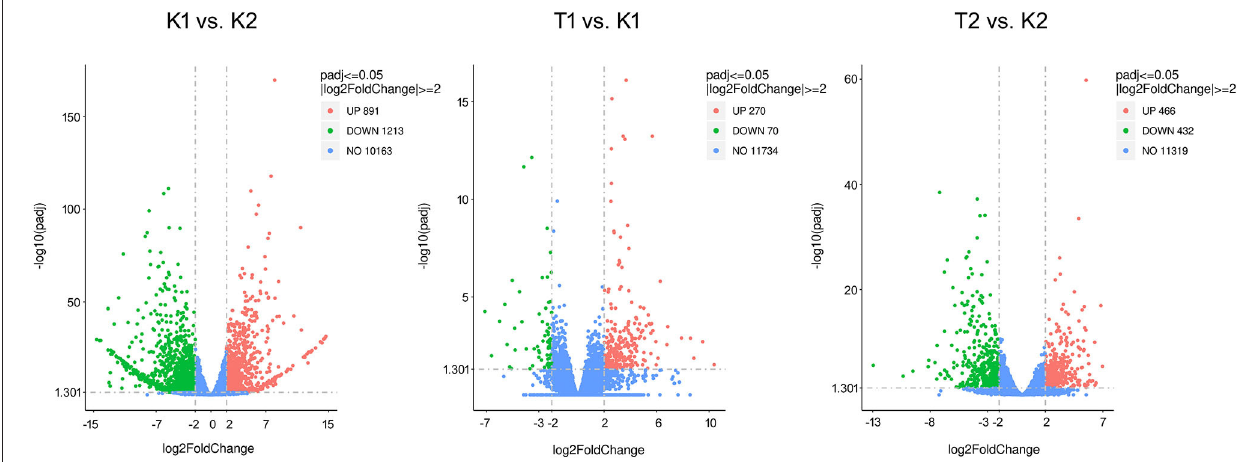
FIGURE 2 | Volcano plot of DEGs in compared groups. The criteria to filter DEGs between compared groups are p ≤ 0.05 and |log2FoldChange| ≥ 2. The X-axis (log2FoldChange) indicates the fold change in expression of the gene in the compared groups, and the Y-axis (–log10padj) indicates the significance level of the difference in expression of the gene in the compared groups. Red dots indicate upregulated genes and green dots indicate downregulated genes.